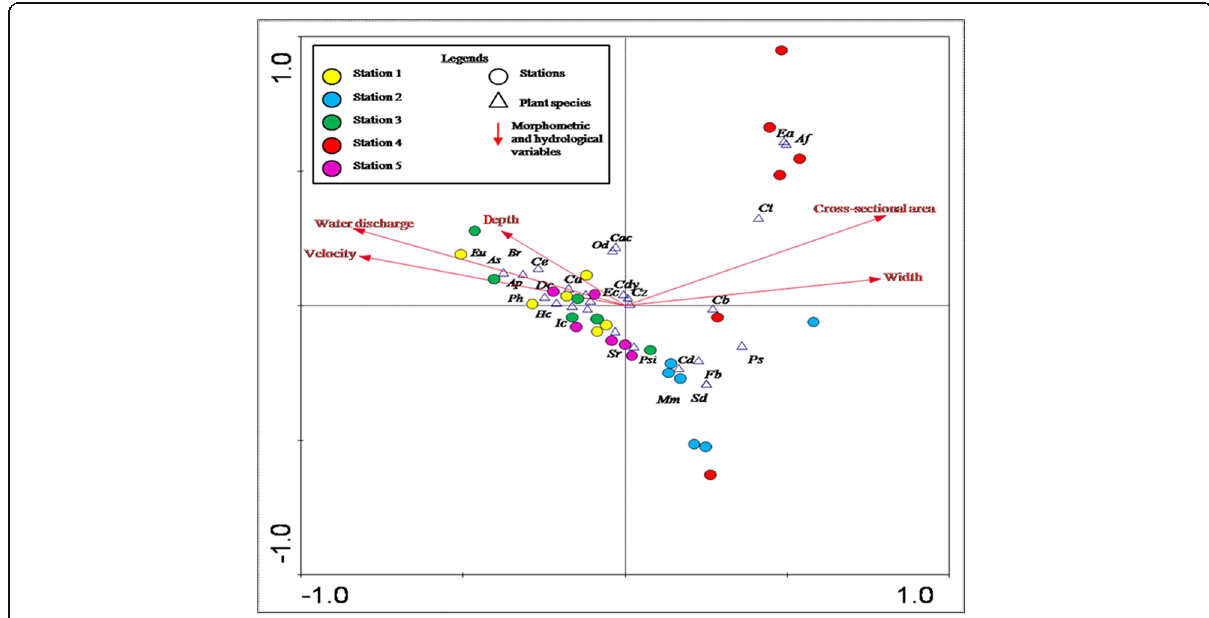
Fig. 5 Ordination plot of CCA elucidating the influence of micro-topography and flow regime on species assemblages. Abbreviations: Af Axonopus fissifolius , Ap Alternanthera paronychioides , As Alternanthera sessilis , Br Brachiaria ramosa , Ca Centella asiatica , Cac Chrysopogon aciculatus , Cb Croton bonplandianus , Cd Ceratophyllum demersum , Cdy Cynodon dactylon , Ce Colocasia esculenta , Ct Calamus tenuis , Cz Chrysopogon zizanioides , Dc Digitaria ciliaris , Ea Eleocharis acicularis , Ec Eichhornia crassipes , Eu Eragrostis unioloides , Fb Fimbristylis bisumbellata , Hc Hemarthria compressa , Ic Ipomoea carnea , Mm Melastoma malabathricum , Od Oldenlandia diffusa , Ph Persicaria hydropiper , Ps Paspalum scrobiculatum , Psi Pseudoraphis spinescens , Sd Schumannianthus dichotomus , Sr Saccharum ravennae